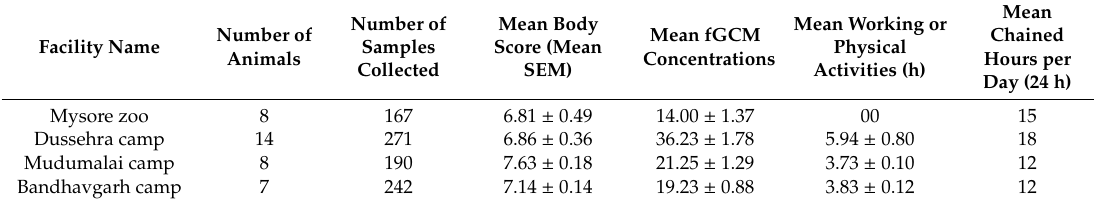
Table 2. Data on sample collection, mean ± SEM body score, fecal glucocorticoid metabolite concentrations (fGCM), and management information.